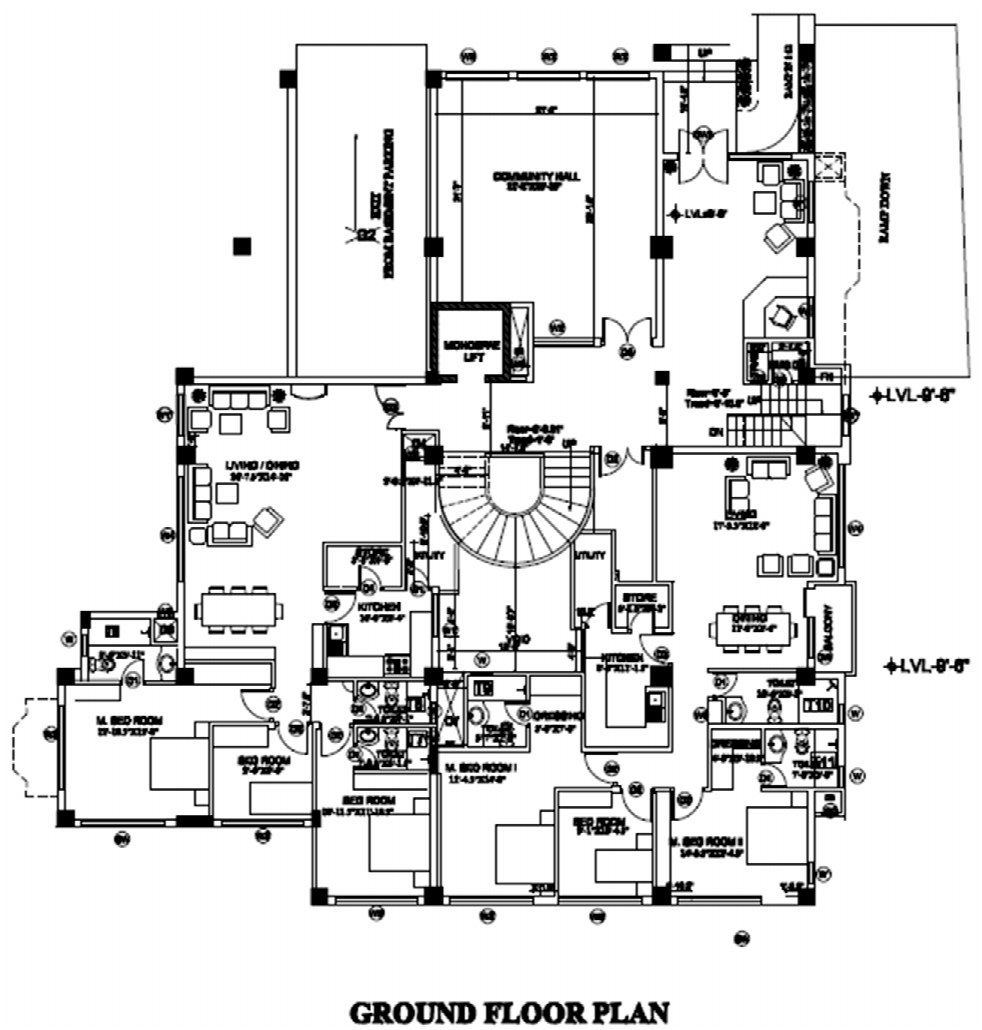
Figure 2. Ground floor plan of the case study building.